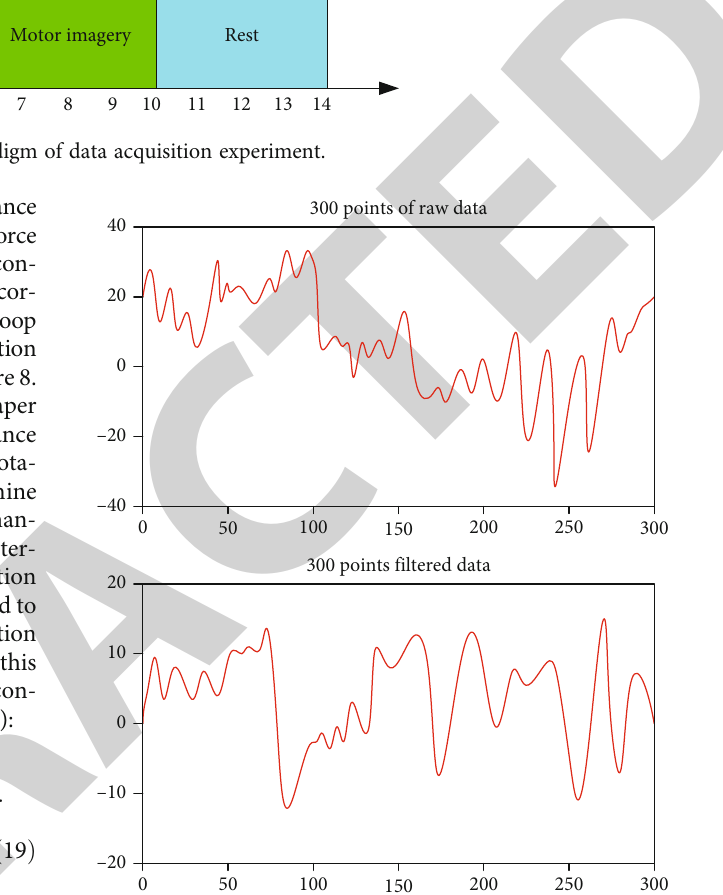
Figure 11: Images before and after fi ltering the EEG signal of C3